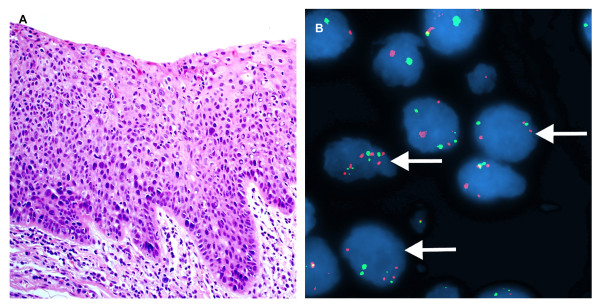
A case of carcinoma in situ . A. H&E stain. (×200). B. Interphase FISH displaying a CSP3: hTERC signal pattern is 2:3, 4:4, 6:6, and etc. (×1000).